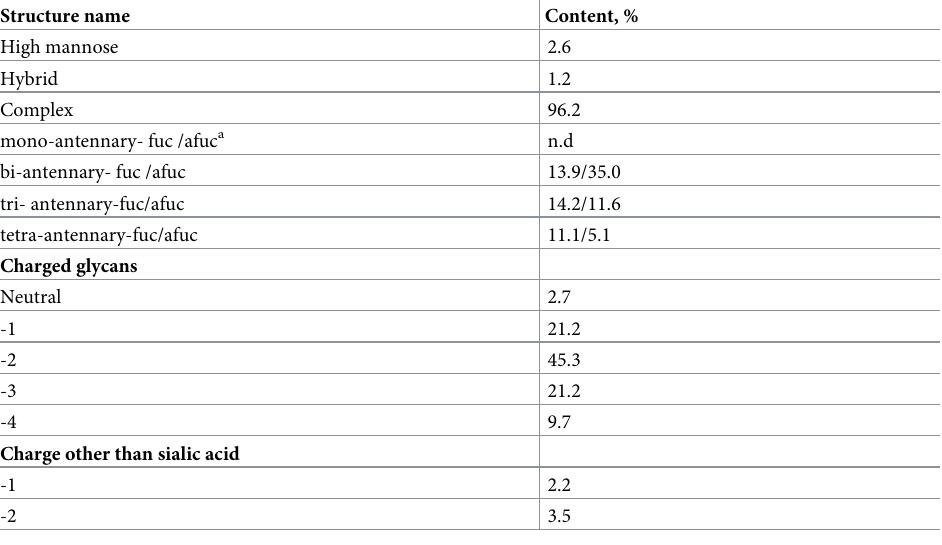
Table 1. Glycan structures and abundance in the purified FSH sample, obtained from the G4 cell